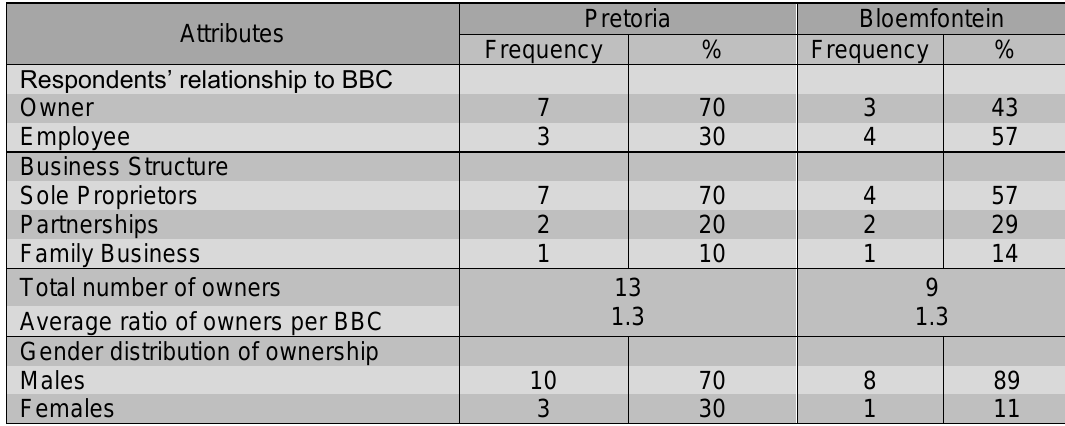
Table 1: Institutional profile of the buy-back centres (Pretoria n=10; Bloemfontein n=7) Attributes